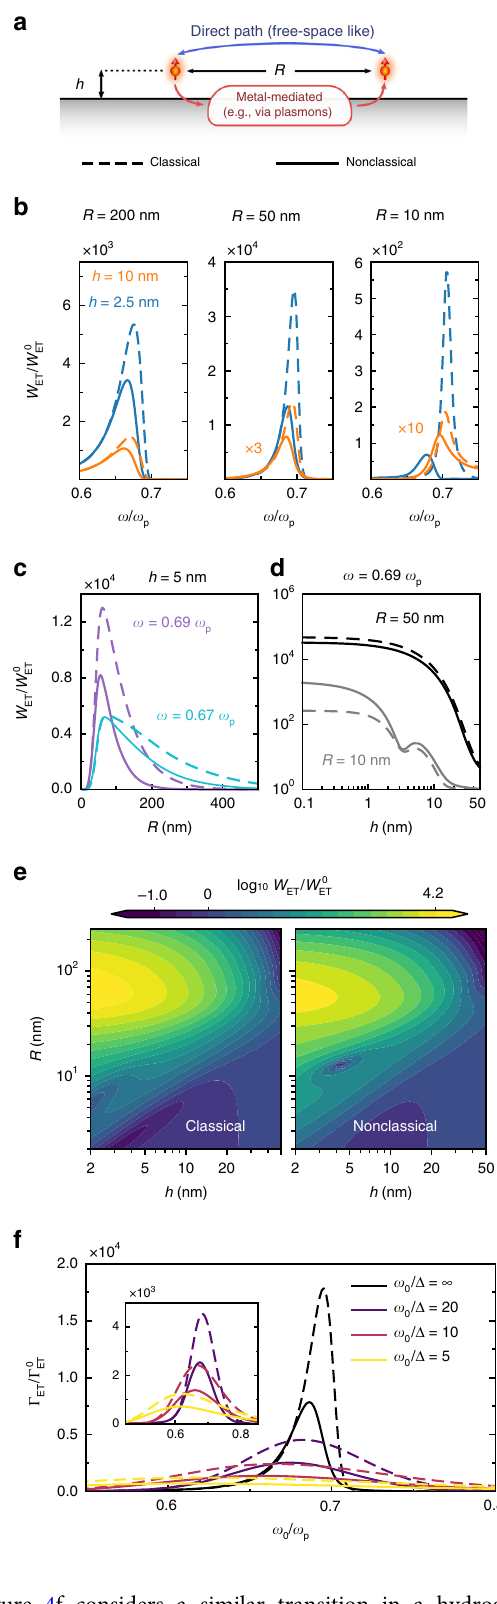
Figure 4f considers a similar transition in a hydrogen-like atom, but now occurring at a higher frequency — i.e., closer to ffiffiffi p = — and thus probing larger plasmon wavevectors. We ω 2 p assume, for simplicity, that the magnitude of the matrix elements in Eq. (8) still equal those in the 6{p, d, f, g, h} ! 2s hydrogen